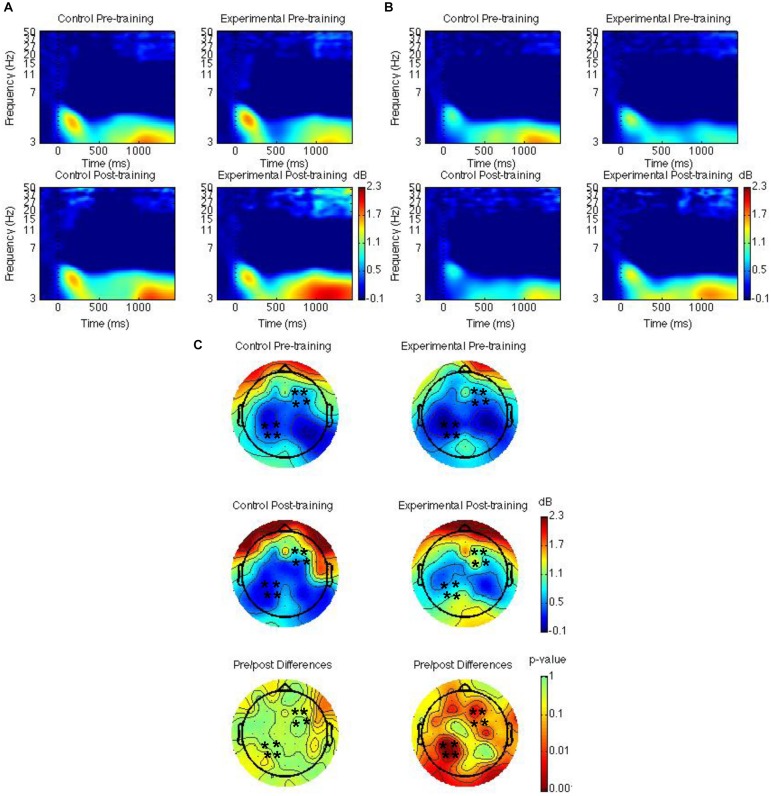
Theta power for the mindfulness meditation experimental and the waitlist control group for the pre-training compared to the post-training session. Time-frequency spectrograms across times and frequencies in a right frontal channel (A). Time-frequency spectrograms across times and frequencies in a left parietal channel (B). Theta power across all channels from 1000 to 1500 ms and differences from pre-training to post-training. Black ∗ marks analyzed channels in right frontal and left parietal regions (C). Color scale: decibel change from pre-stimulus baseline and p-value of pre-training to post-training differences.